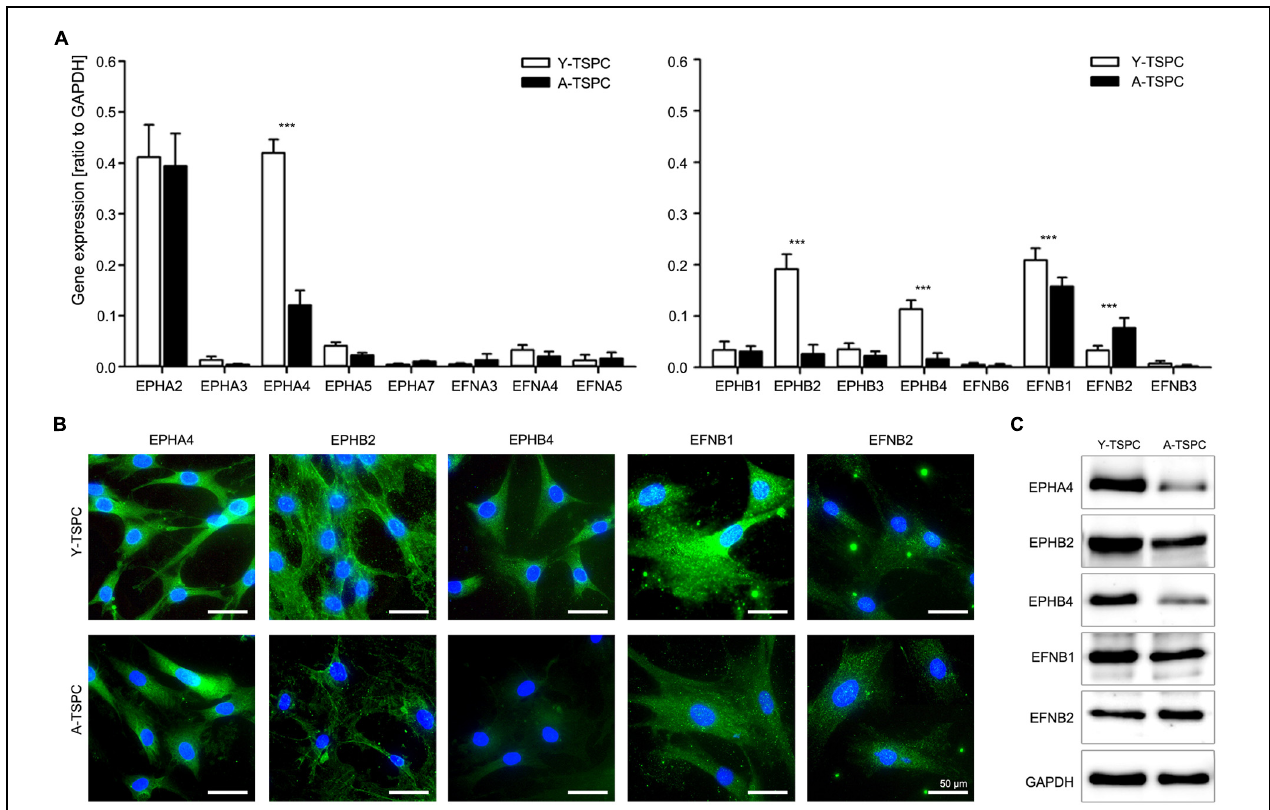
FIGURE 1 | Ephrin expression in tendon stem/progenitor cells (TSPCs). (A) Comparison between Y- and A-TSPC basal ephrin family expression by quantitative PCR array. Data consists of three independent repeats with all three Y-and A-TSPC donors ( n = 9, ∗∗∗ p ≤ 0.001). (B) Cytochemical and (C) western blot protein analysis for EphA4, EphB2, EphB4, EFNB1, and EFNB2 in Y- and A-TSPC ( n = 6; full blot shown in Supplementary Figure S1 ). Representative images; bars = 50 μ